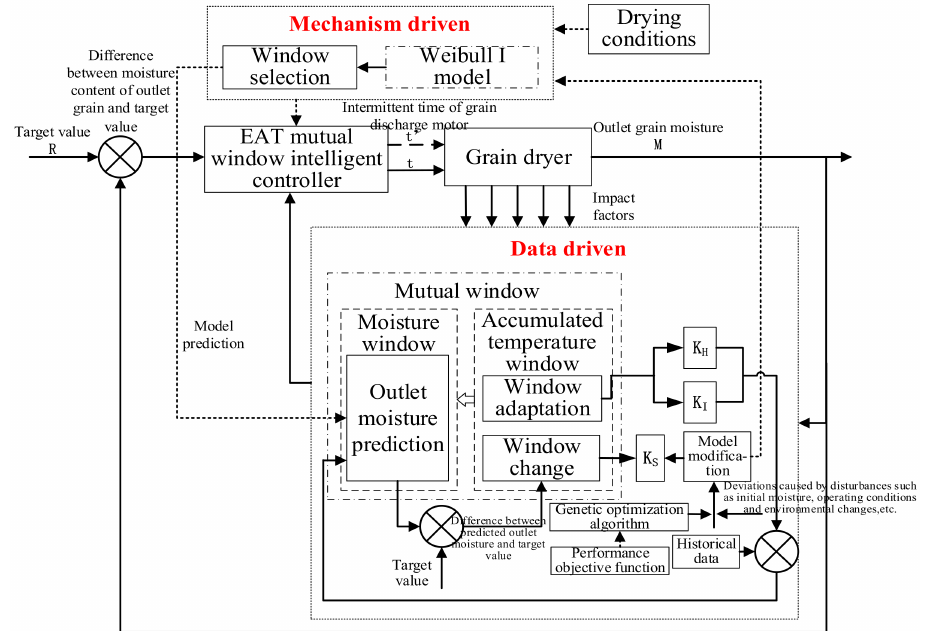
Figure 2. Schematic diagram of drying process control